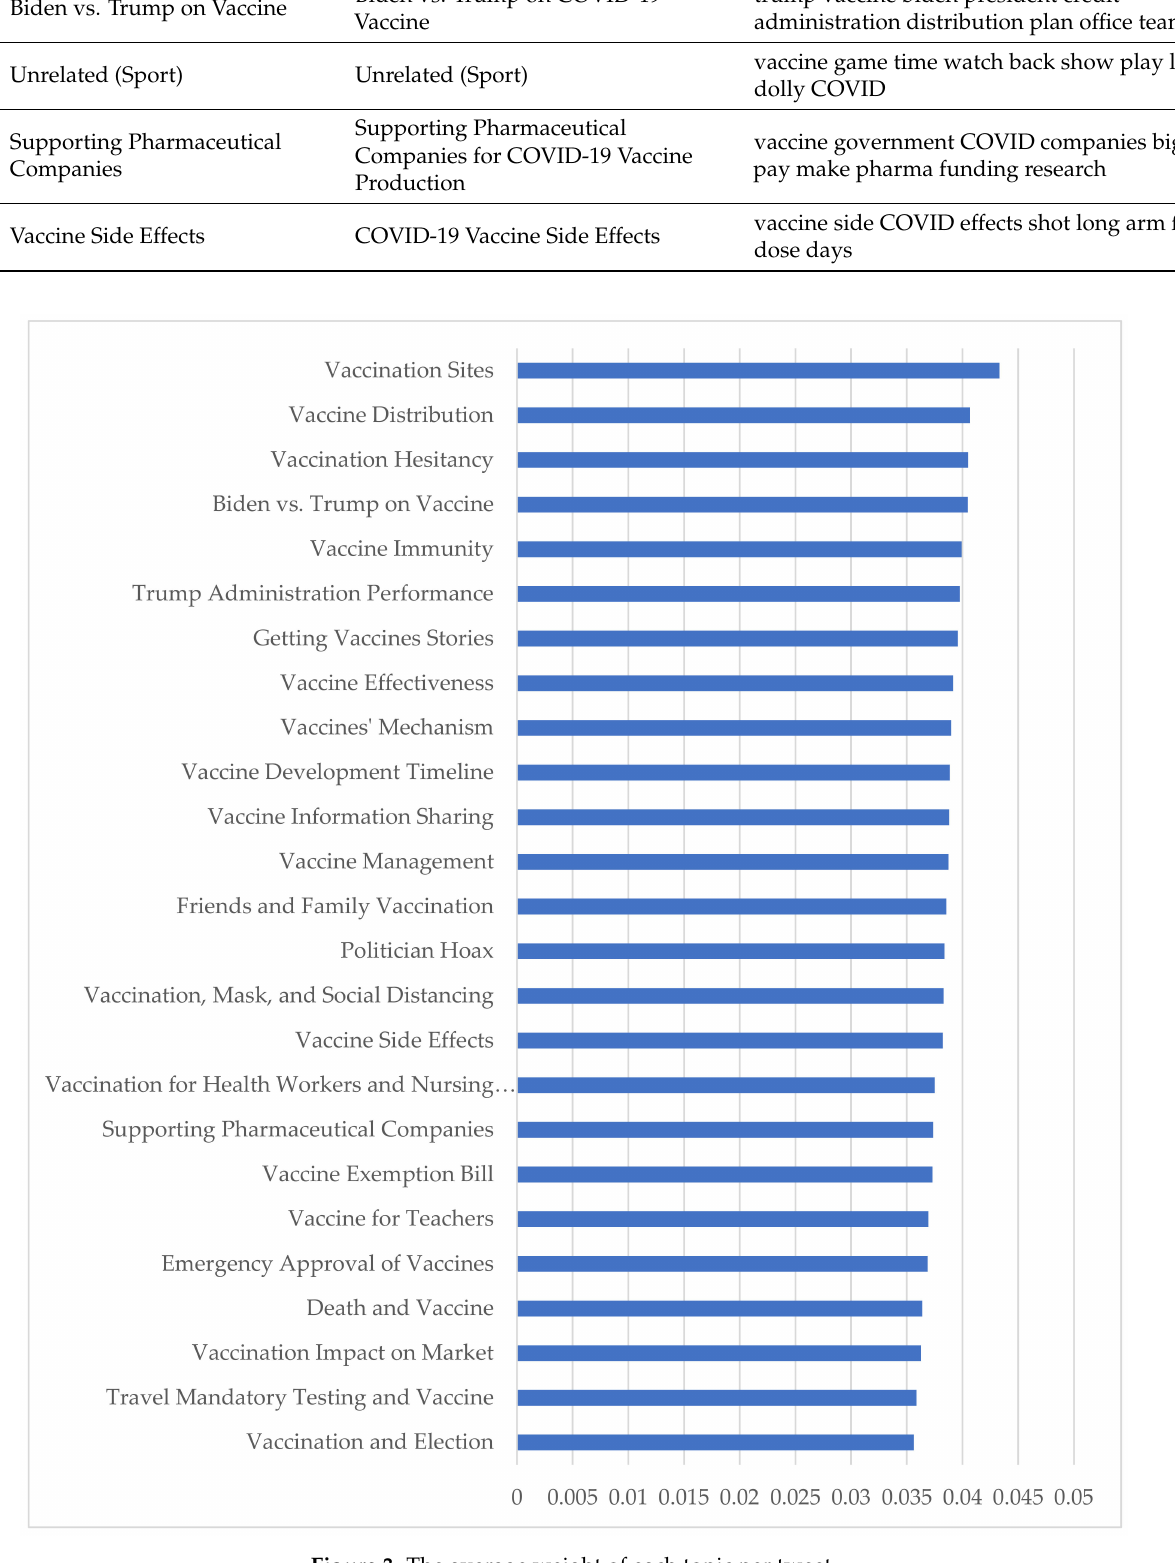
Figure 3. The average weight of each topic per